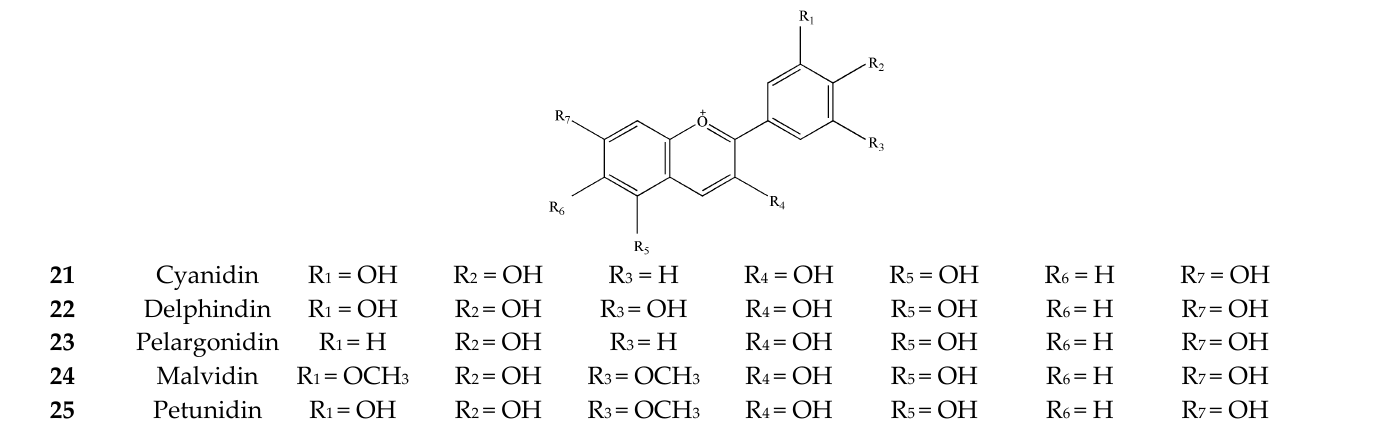
Figure 2. Chemical structures of flavonoids isolated from green tea.